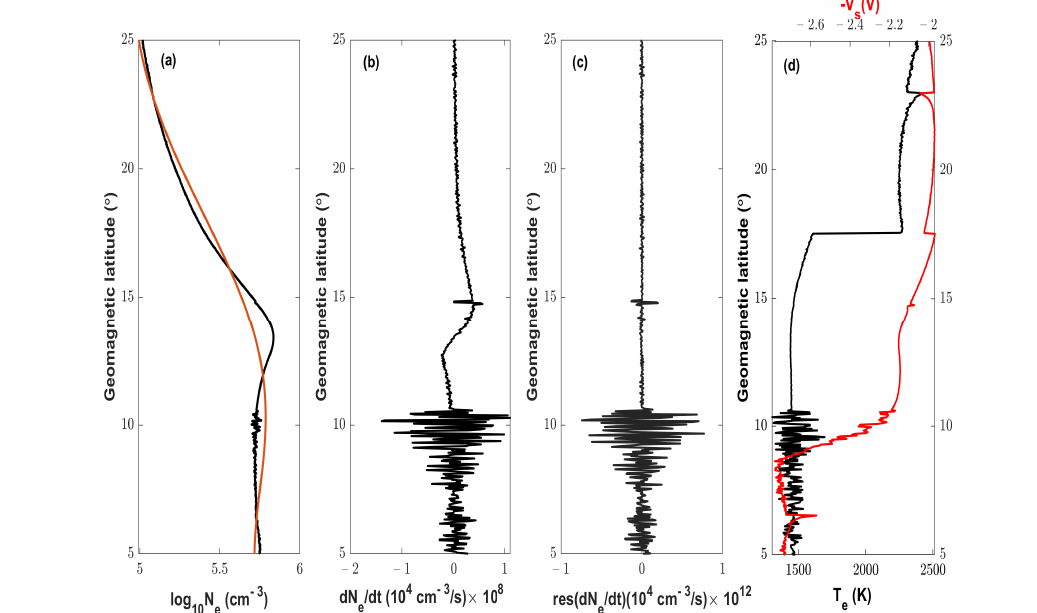
Figure 18. Detection of anomalous track identified by NeLOG algorithm in electron density. Latitudi- nal ( a ) electron density variation in lograrithmic scale, ( b ) rate of change of electron density variation, ( c ) residual of rate of change of electron density, ( d ) electron temperature (black curve) and potential (red